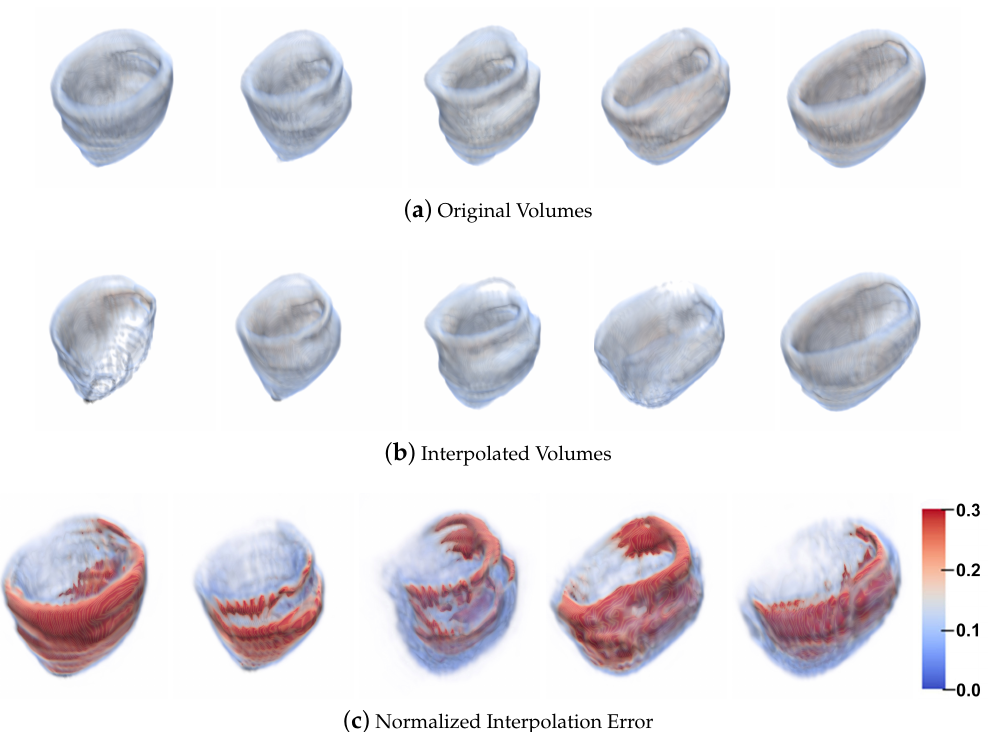
Figure 19. Left Ventricle from 30% to 70% of the cardiac cycle and the results with 3D method of Sun et al. [20].